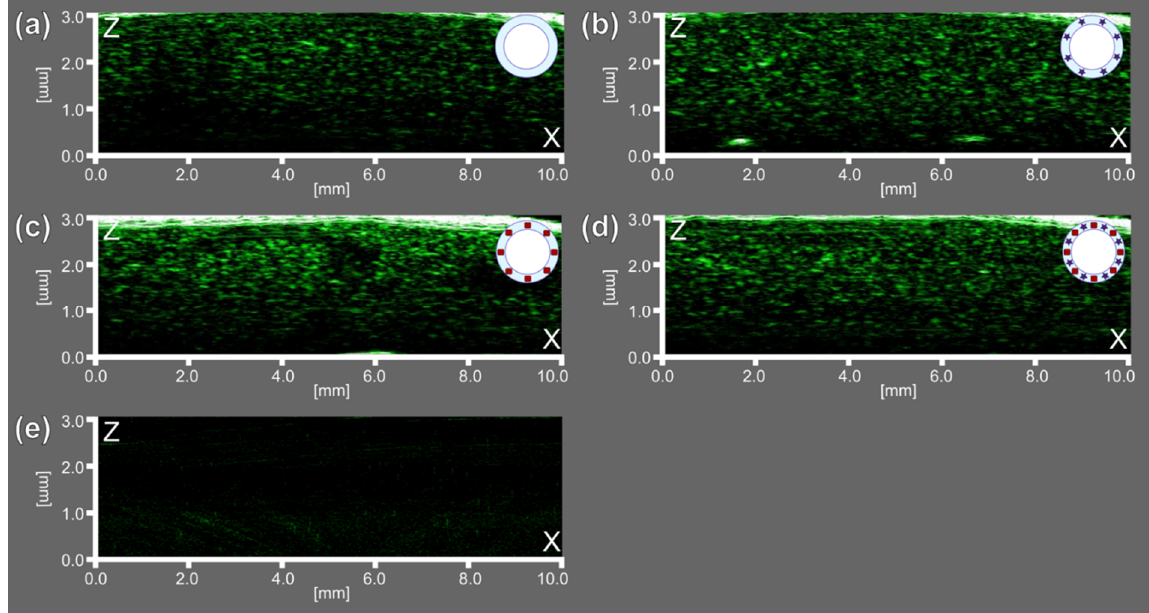
Figure 7. Ultrasound (US) imaging at a frequency of 33 MHz for ( a ) BSA MBs, ( b ) BSA-ZnPc MBs, ( c ) BSA-Au MBs, ( d ) BSA-Au-ZnPc MBs, and ( e ) saline solution.